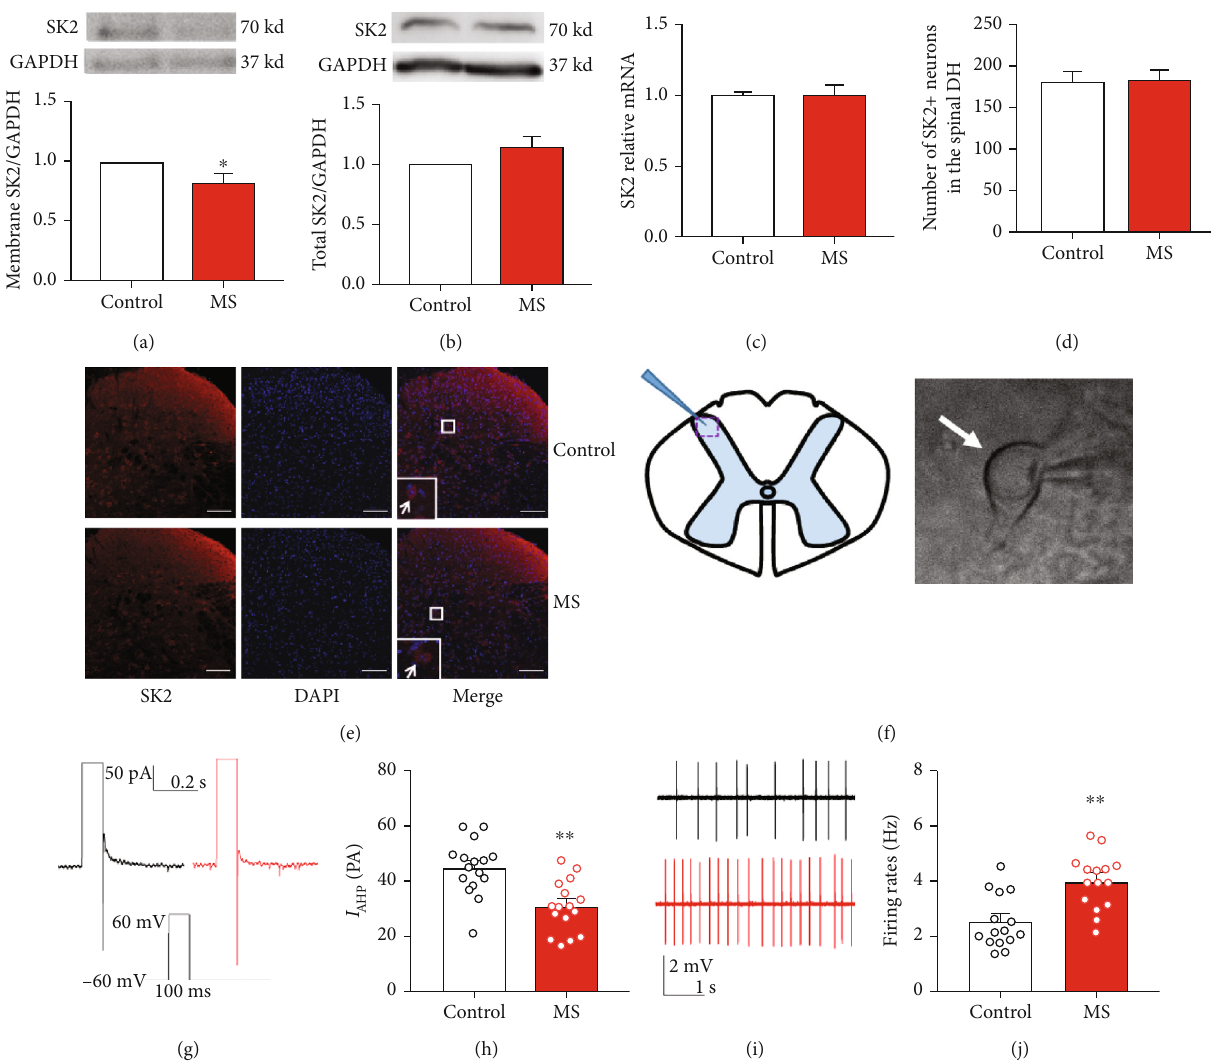
Figure 3: SK2 protein expressions in the membrane fraction, SK2 mRNA, and I AHP were reduced in mice with neonatal MS. (a) Spinal SK2 protein in the membrane fraction presented a signi fi cant decrease in mice with the neonatal MS versus control mice ( t -test, t = 2 : 77 , P < 0 : 05 , n = 6 per group). (b) There was no di ff erence in total spinal SK2 channel protein in mice with the neonatal MS versus control mice ( t -test, t = 1 : 53 , P = 0 : 157 , n = 6 per group). (c) Consistently, there was also no di ff erence in total spinal SK2 mRNA in mice with the neonatal MS versus control mice ( t -test, t = 0 : 16 , P = 0 : 877 , n = 9 per group). (d) There was no di ff erence in the number of SK2+ neurons in the spinal dorsal horn between the two groups ( t -test, t = 0 : 29 , P = 0 : 783 , n = 4 per group). (e) SK2 channel immunostaining, scale bar = 100 μ m. (f) Schema of patch-clamp recording. (g, h) The average peak amplitude of I fi cantly reduced AHP in the neonatal MS mice was signi versus that in the control mice ( t -test, t = 4 : 18 , P < 0 : 01 , n = 16 neurons/5 mice per group). (i, j) The spontaneous neuronal fi ring rates in the spinal DH increased signi fi cantly in the neonatal MS mice versus the control mice ( t -test, t = 4 : 19 , P < 0 : 01 , n = 15 neurons/5 mice per group). Data are expressed as mean ± SEM , ∗∗ P < 0 : 01